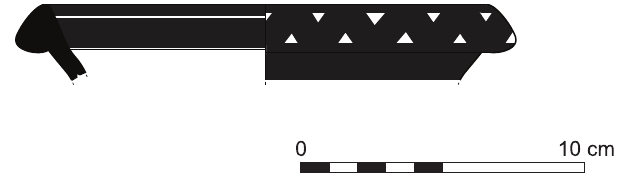
Fig 46. Rim and body fragment of an amphora, White Painted IV